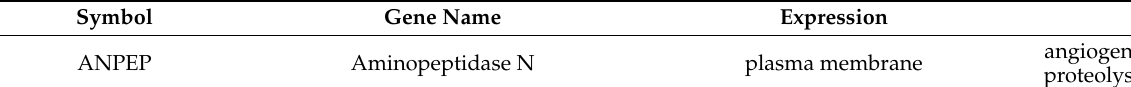
Table 3. Twenty-one common DEGs related to ‘cell